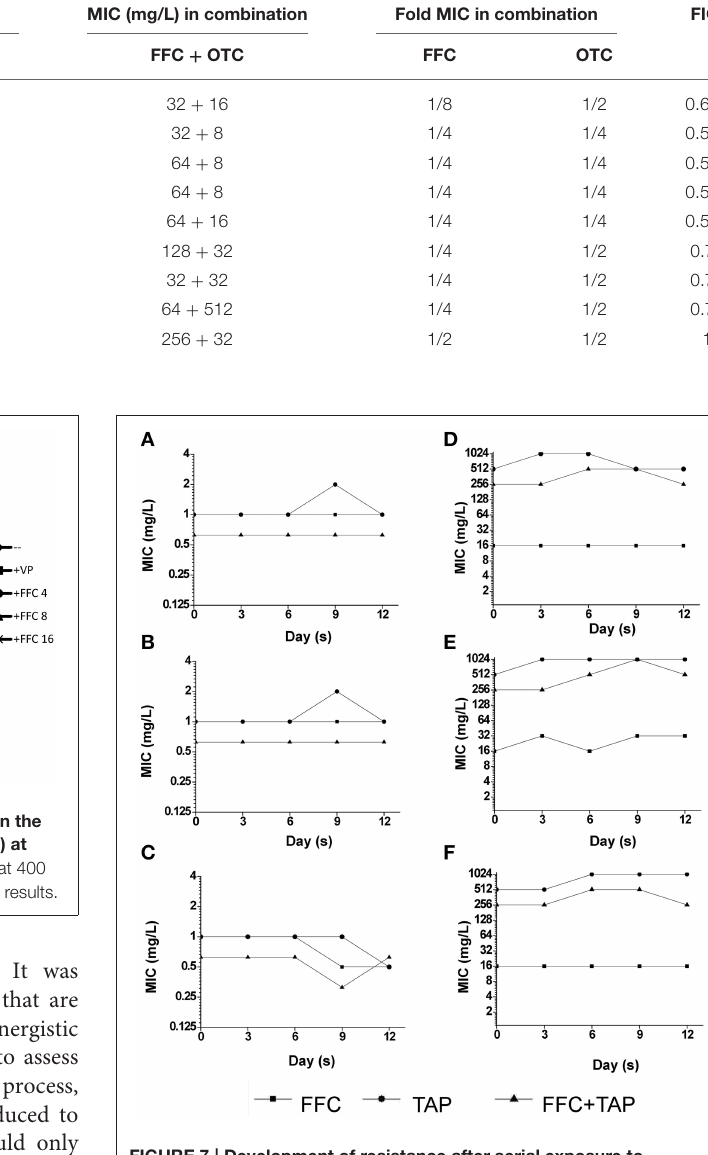
FIGURE 7 | Development of resistance after serial exposure to florfenicol (FFC), thiamphenicol (TAP) and FFC + TAP. Serial passage of P. multocida (0425) (A–C) and (101-035) (D–F) exposed to sub-MIC levels of florfenicol (FFC) (A,D) , thiamphenicol (TAP) (B,E) , and FFC + TAP (C,F) . MIC of each point was determined at least in triplicates. The experiment was repeated three times with similar